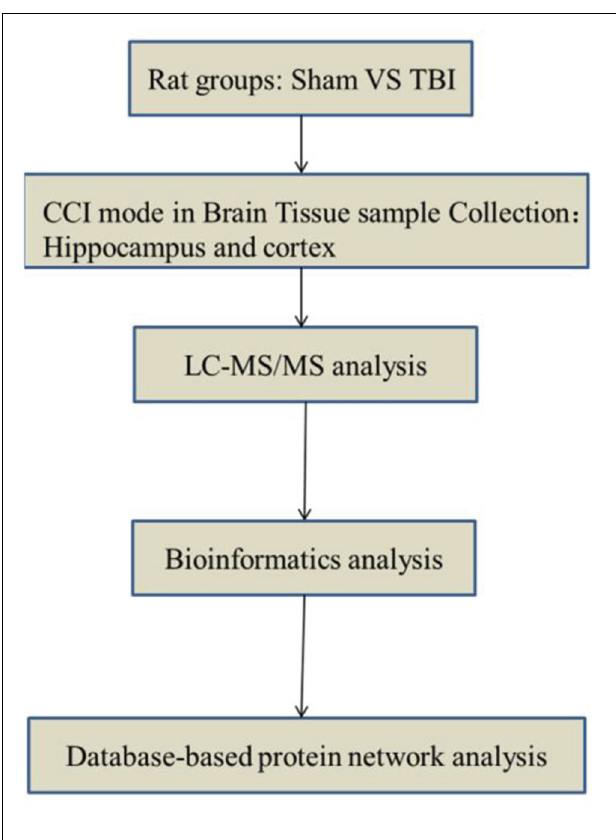
FIGURE 1 | Flow chart of the study design.